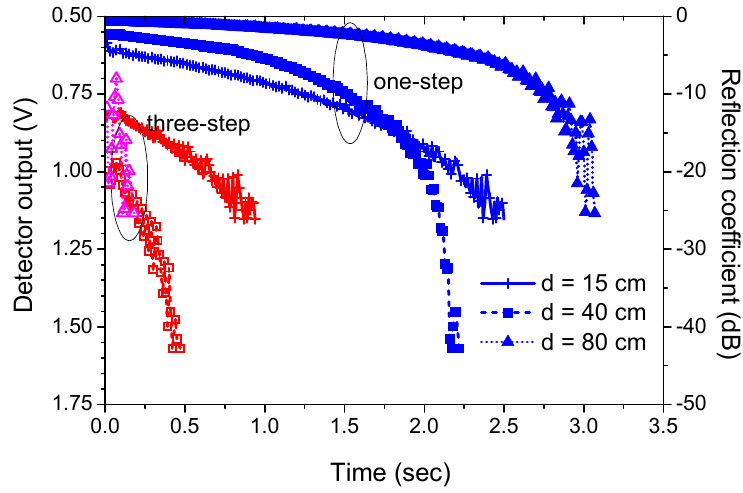
Figure 12. Measured detector output and reflection coefficient versus time at three distances: d = 15 cm, 40 cm, and 80